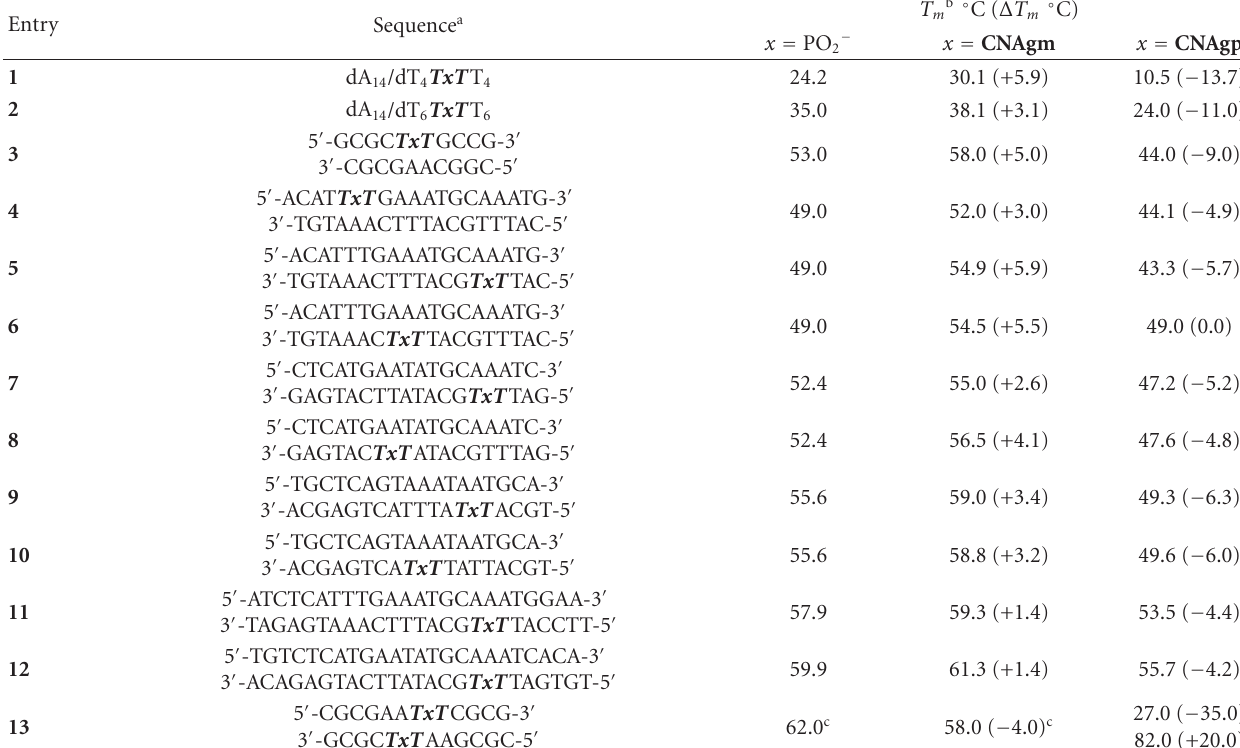
Table 3: Comparison of melting temperatures of CNAgm or CNAgp containing